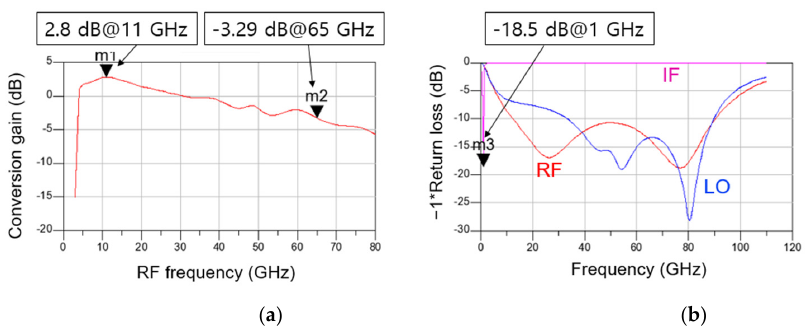
Figure 13. Simulated ( a ) CG versus RF frequency and ( b ) return loss versus frequency of the distributed cascode mixer.